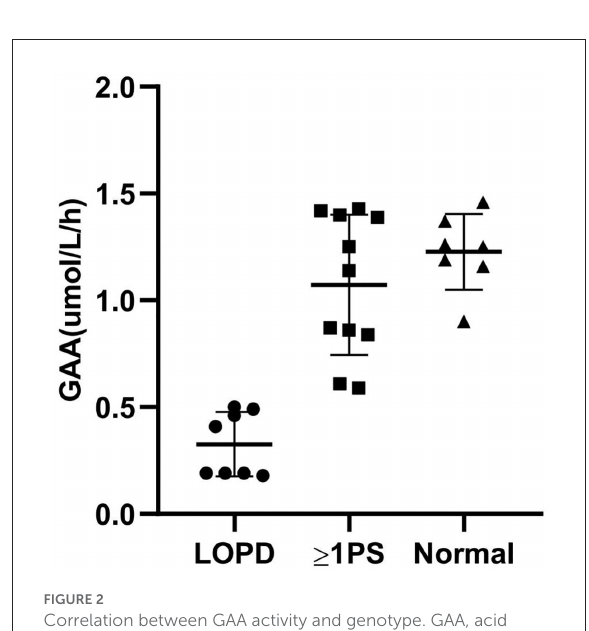
FIGURE2 Correlation between GAA activity and genotype. GAA, acid α -1,4-glucosidase; LOPD, late-onset Pompe Disease; PS, pseudodeficiency with or without GAA mutations; Normal, normal controls.